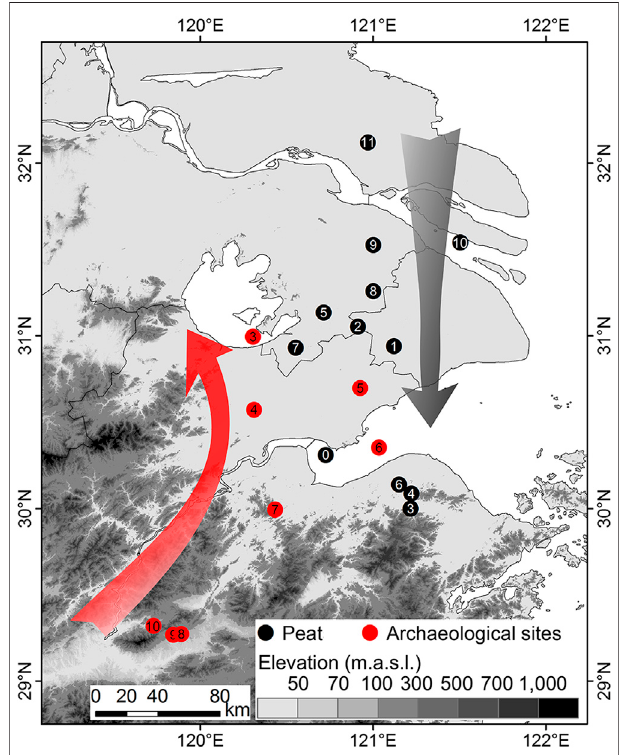
FIGURE 2 | Mean centers of radiocarbon dates of archaeological sites andpeatper1,000 years.Numbersinthecirclesindicatetheuppertimelimits per1,000 yearsofmeancenters;e.g.,11suggests12,000 – 11,000 cal yrBP. Arrows indicate the shift directions of the mean centers. DEM data are provided by the Geospatial Data Cloud site, Computer Network Information Center, and Chinese Academy of Sciences (http://www.gscloud.cn).